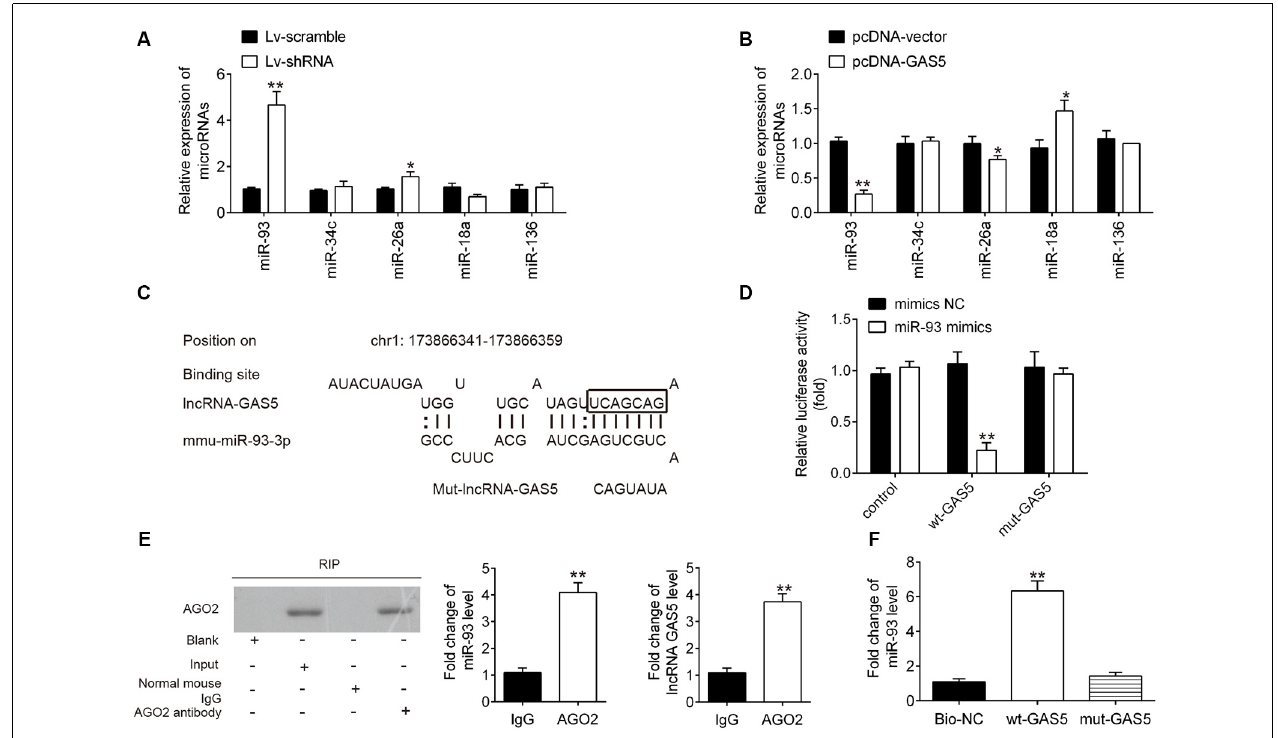
FIGURE 4 | Interaction between long noncoding RNA (lncRNA) growth arrest–specific transcript 5 (GAS5) and miR-93. (A,B) Expressions of miR-93, miR-26a, miR-34c, miR-18a, and miR-136 as measured using quantitative reverse transcription polymerase chain reaction (qRT-PCR) analysis after lentivirus short-hairpin RNA (LV-shRNA) infection or pcDNA-GAS5 transfection in HT22 cells. Untreated cells served as control. Data represent the mean ± SD of three independent experiments. * p < 0.05, ** p < 0.01 vs. LV-scramble group or pcDNA vector group. (C) Binding sites on lncRNA GAS5 and miR-93. (D) Relative luciferase activity of HT22 cells cotransfected with miR-93 mimics/NC and GAS5–3 (cid:48) UTR-WT or GAS5–3 (cid:48) UTR-MUT plasmid. (E) Ago2-RIP followed by Western blotting to assay miR-93 endogenously associated with GAS5. IgG was served as the control. Ago2 in proteins from Ago2-RIP assay was measured by Western blotting. The levels of GAS5 and miR-93 were measured by qRT-PCR. ** p < 0.01 compared with the IgG group. (F) RNA pulldown assay was designed to explore the interaction between GAS5 and miR-93. Data represent the mean ± SD of three independent experiments. ** p < 0.01 vs. negative control or beads